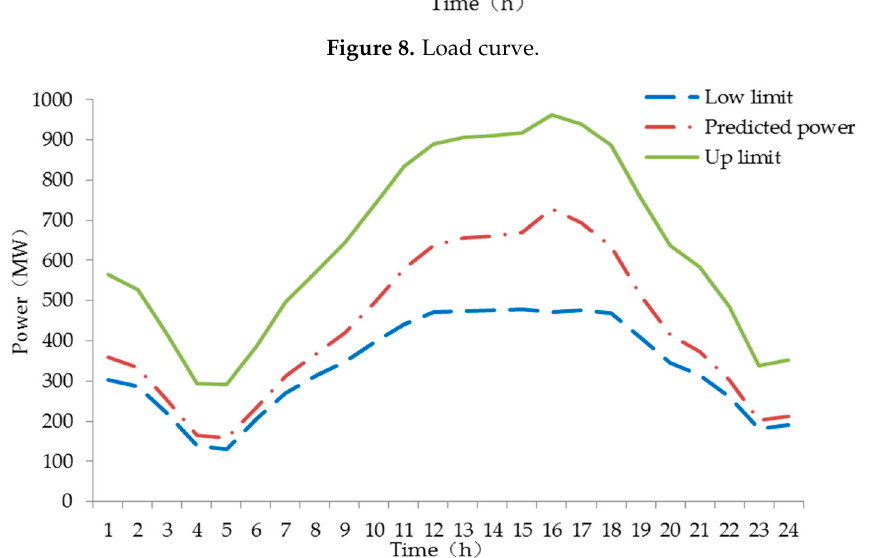
Figure 9. Prediction wind power curve and the power output limit curve of different confidence degrees.